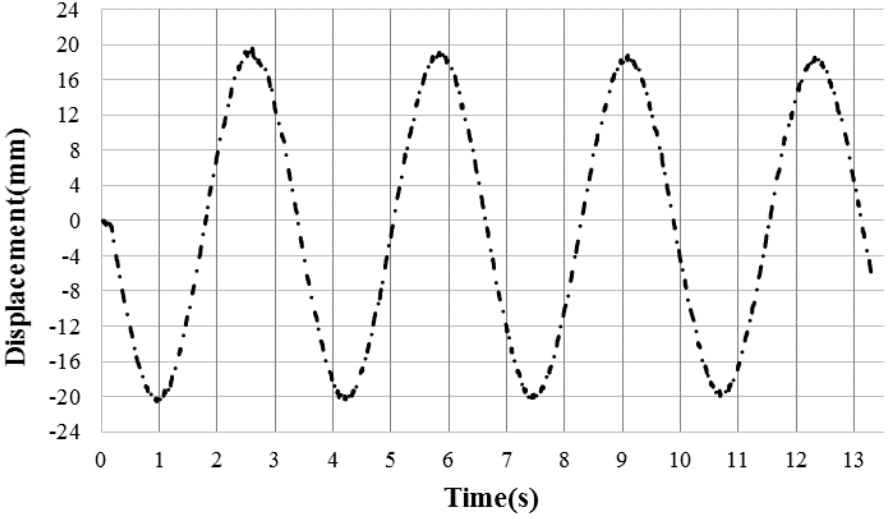
Figure 4. Pendulum motion data recorded by laser for 10 g spherical emulsion explosive in 4 mm standoff distance.